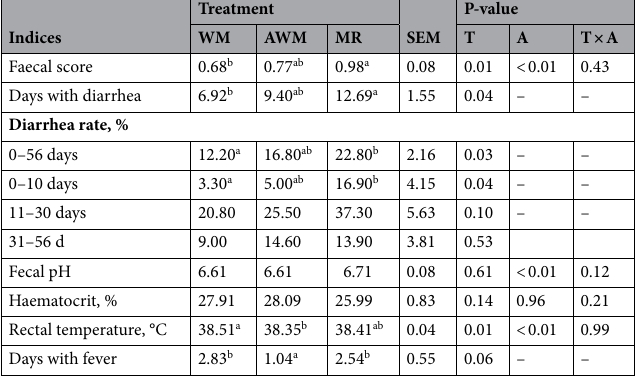
Table 3. Diarrhea and health of preweaning dairy calves fed different liquid diets. WM whole milk, AWM acidified whole milk, MR milk replacer, SEM standard error of the mean, T treatment effect, A age effect, T × A treatment × age interaction effect ( P < 0.05). a , b Means within a row with different superscripts are significantly different (P ≤